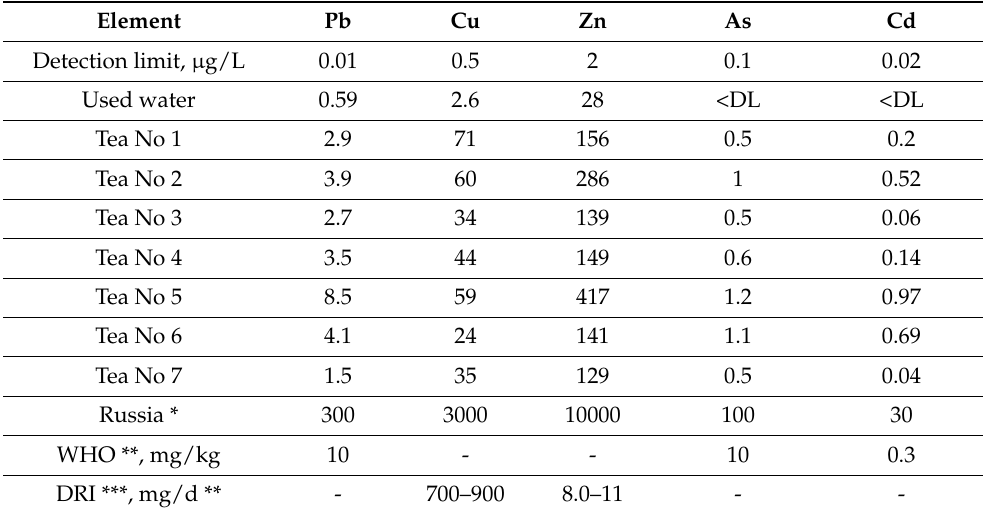
Table 7. Results of ICP-AES and ICP-MS analyses of heavy metals in tea infusion ( µ g/L) in compari- son with maximum permissible concentrations.